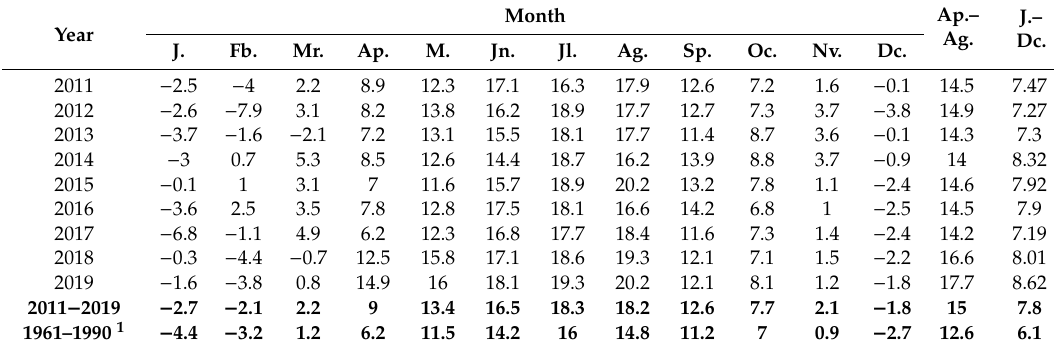
Table 3. Mean temperatures ( ◦ C) during the course of